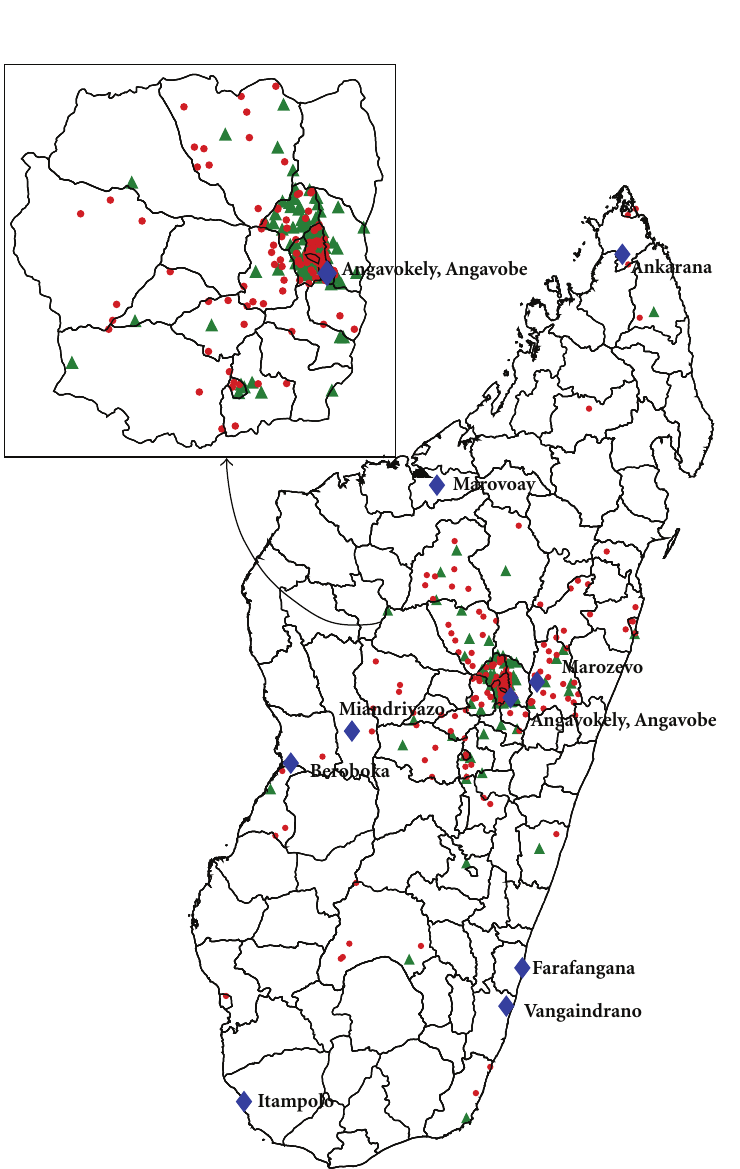
Figure 2: Distribution of the human and nonflying animal samples tested negative (green-filled triangle) and positive (red-filled circle) for rabies, and sites of bats sampling (blue-filled diamond) in Madagascar,